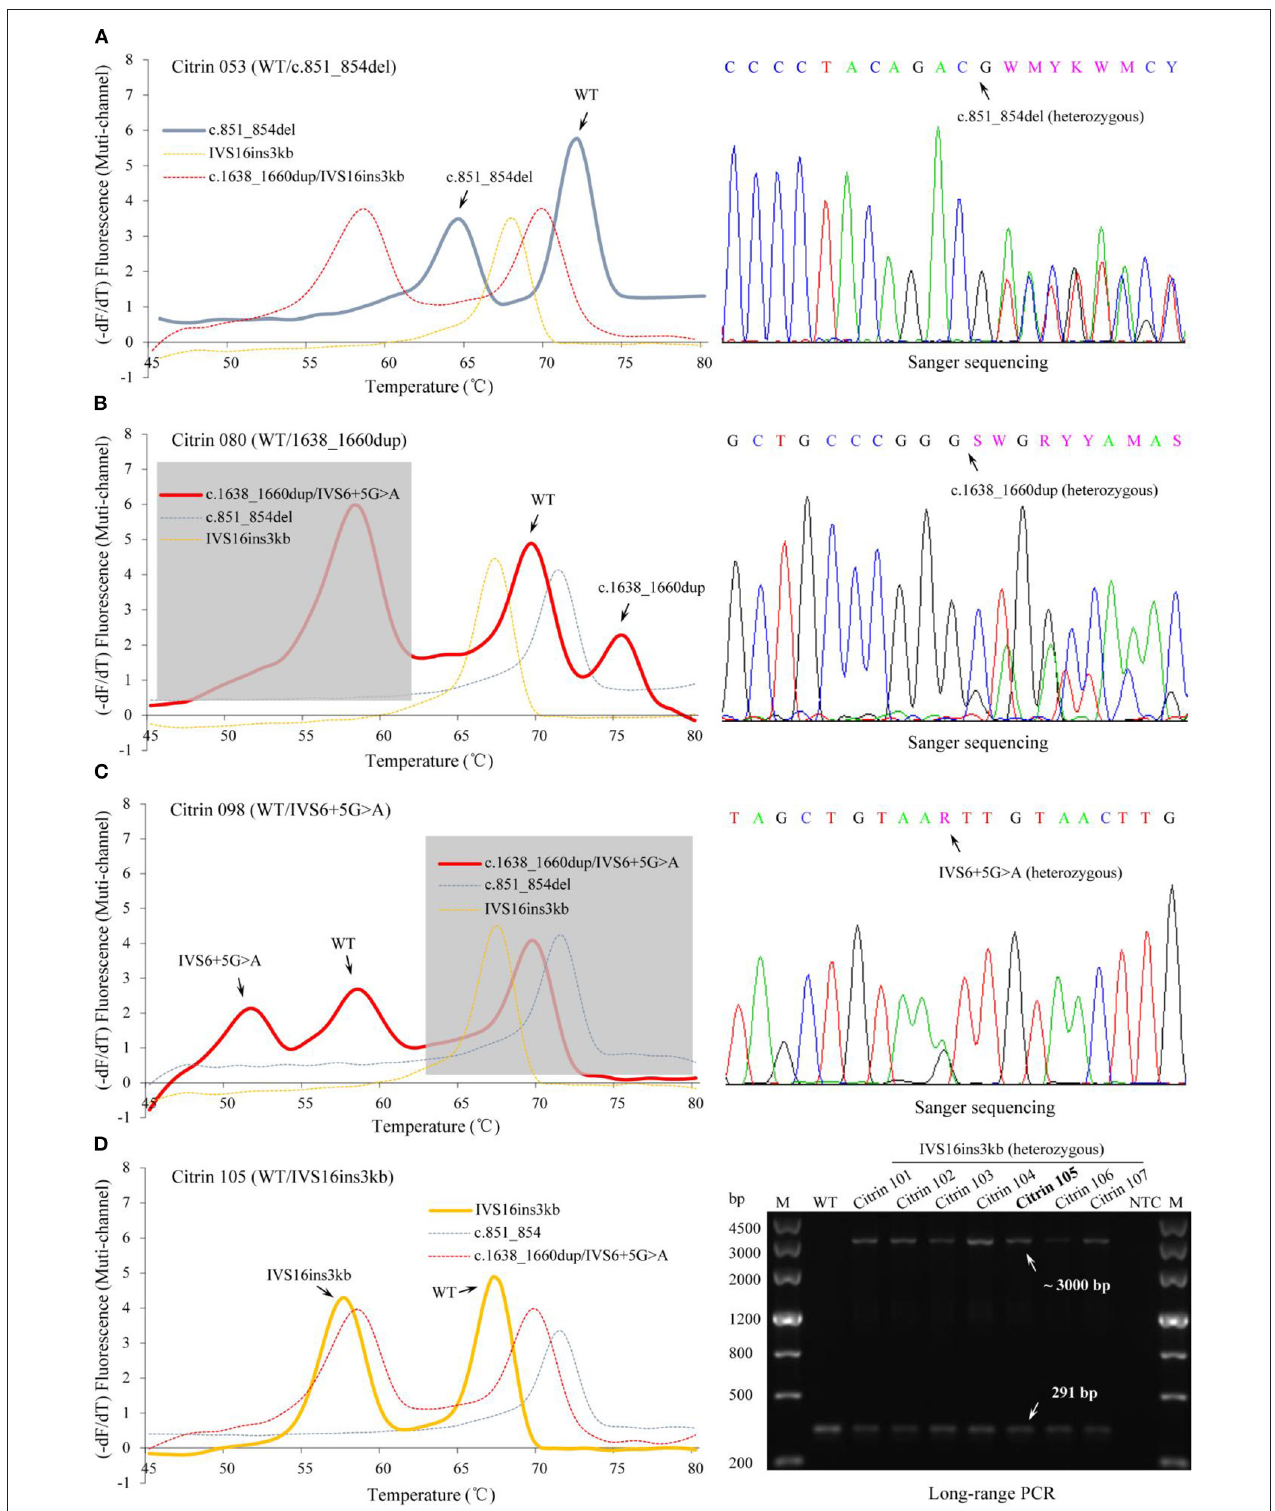
FIGURE 3 | Identification of SLC25A13 genotypes in the newborn cohort using the MMCA assay. Representative melting curves and fluorescence melting peaks of 4 SLC25A13 -mutation carriers are presented in the left panels, and the specimen number and genotype of each mutation carrier are marked above the